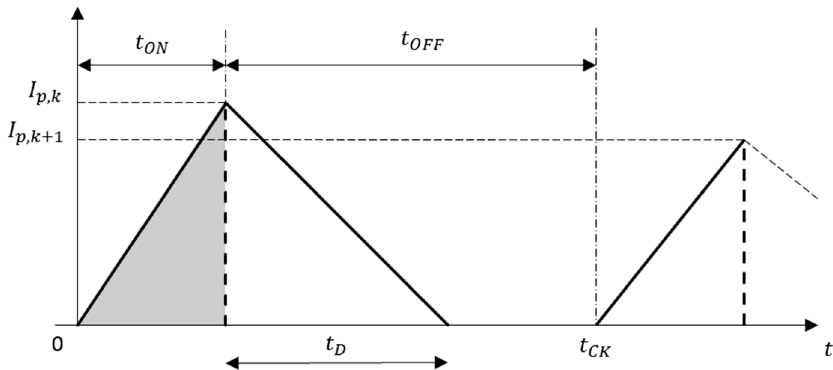
Figure 8. Switched curret waveform.